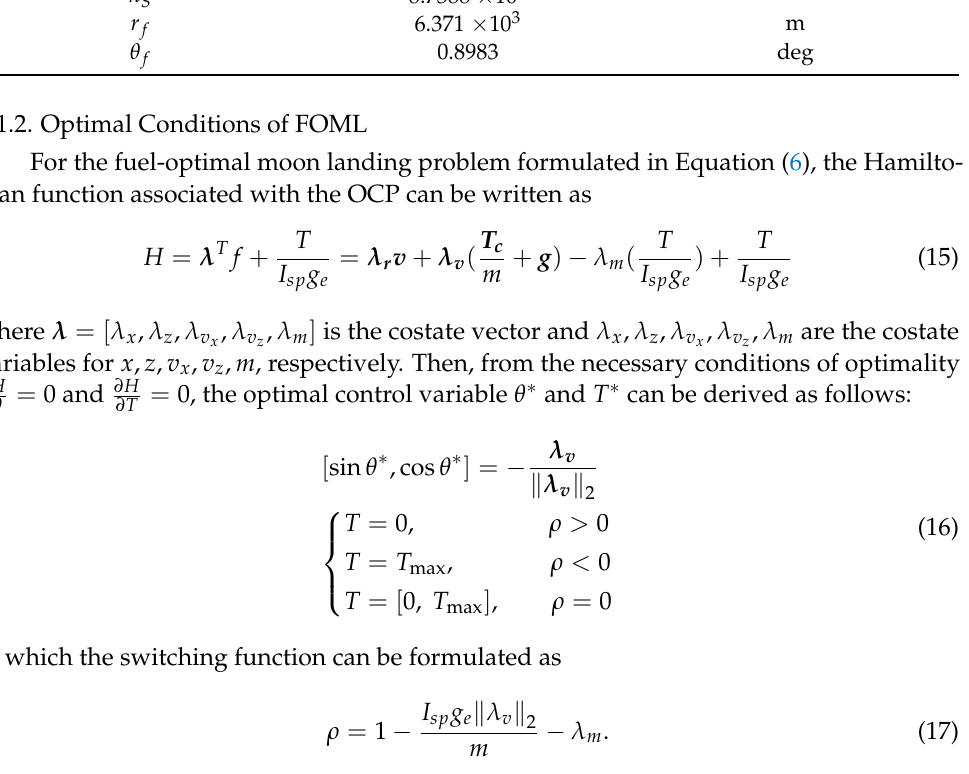
Table 1. The parameters for the unpowered flight of the hypersonic vehicle. Parameter Value Unit m